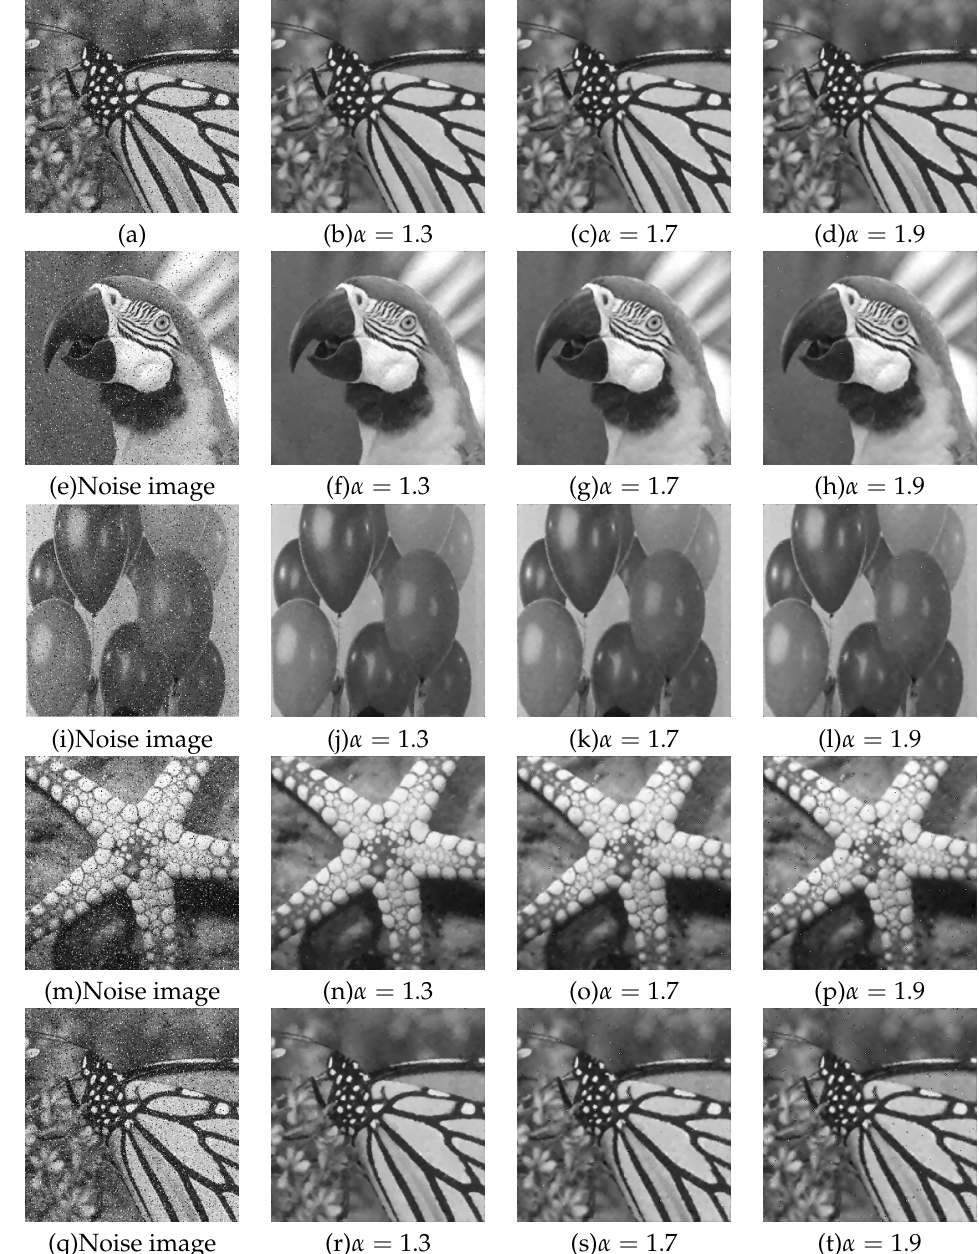
Figure 3. The restored image obtained by our proposed method with different α